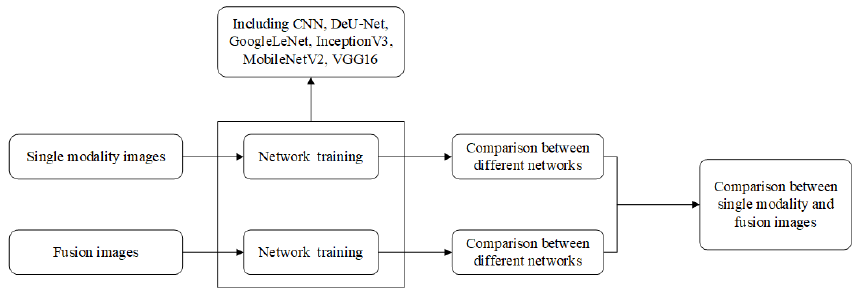
Figure 12. Network training diagram.